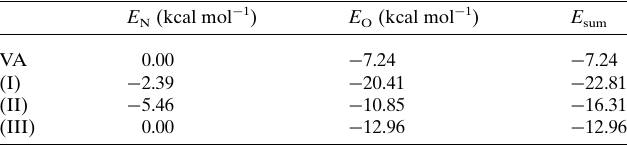
Table 4 The sum of weak-interaction energies involving N2A and O1A atoms as acceptors of hydrogen